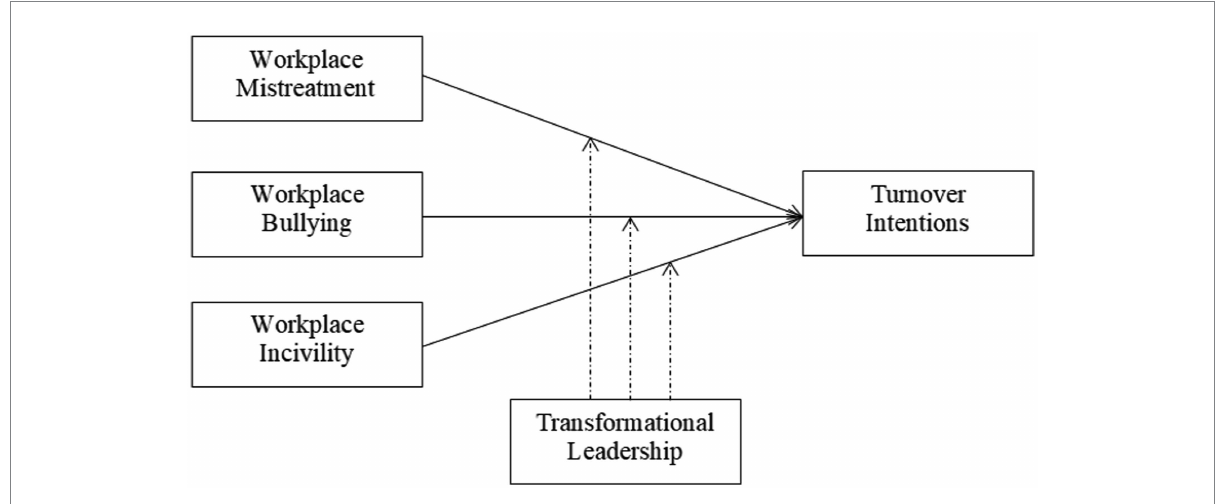
FIGURE 1 Conceptual